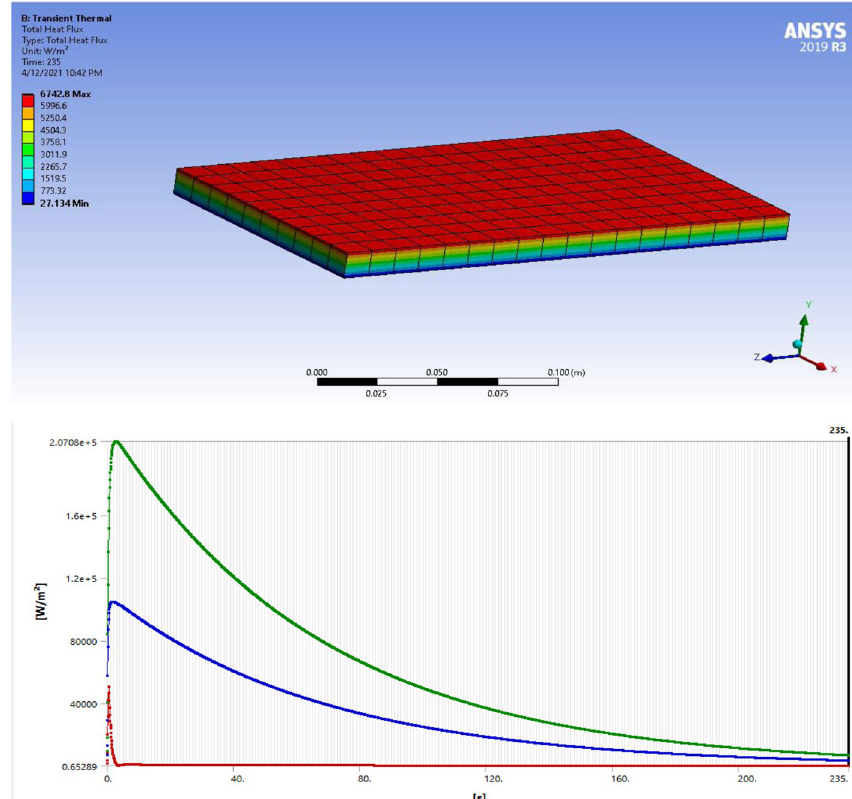
Table 11 Experimental